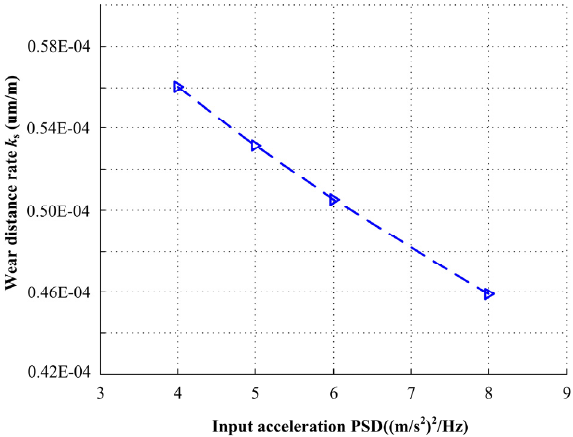
Figure 14. Wear distance rate under different input acceleration PSDs.